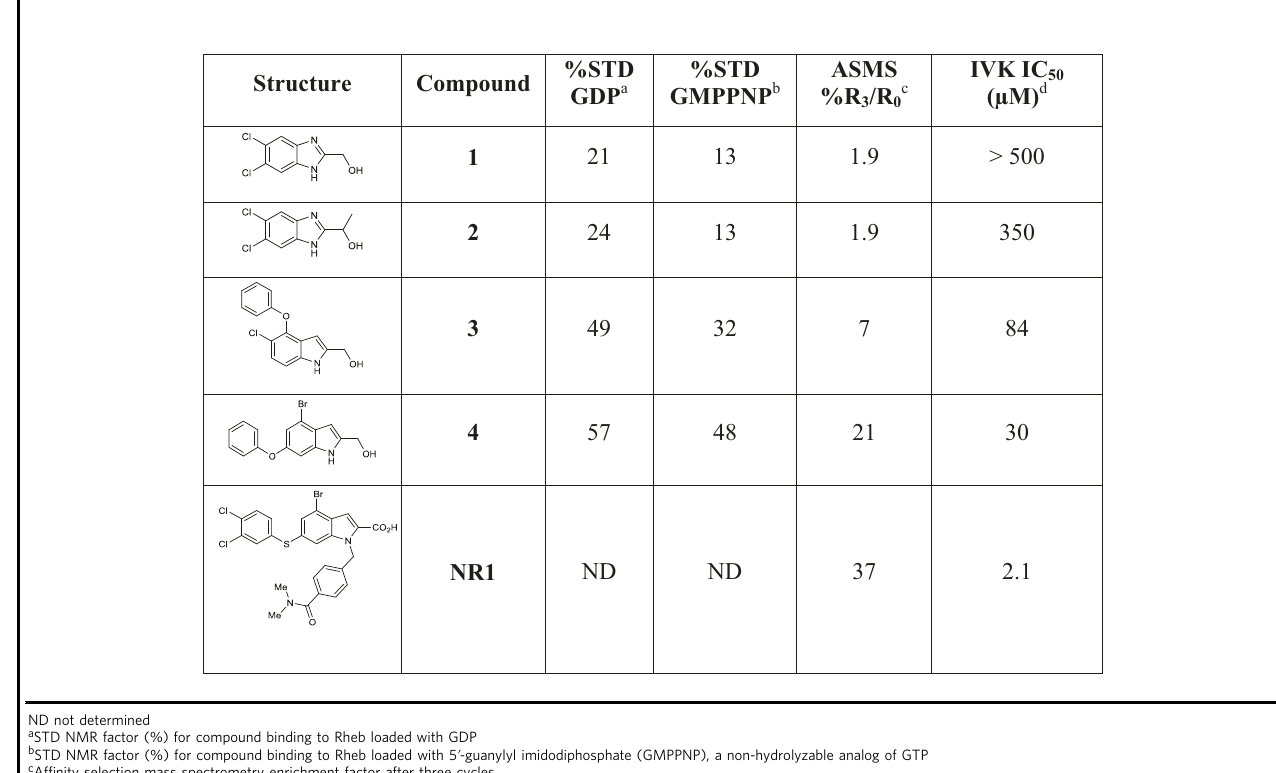
Table 1 Structure – activity relationships of select compounds showing Rheb binding and functional activity